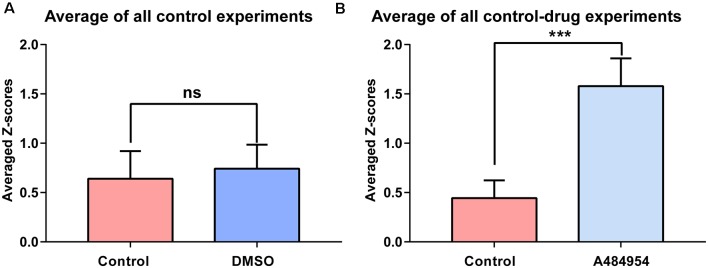
The effects of DMSO and A484954 on synchronicity of fluorescence transients between different CA3 areas over all experiments. (A) The bar graph indicates that DMSO did not affect the level of synchronization between different CA3 areas (control: 0.74 ± 0.24; DMSO: 0.64 ± 0.28; n = 5, ns, unpaired t-test). (B) The bar graph shows that A484954 enhanced significantly the synchronized activity of different areas of the CA3 region (control: 1.57 ± 0.28; A484954: 0.44 ± 0.18; n = 8, ***P < 0.01, unpaired t-test).